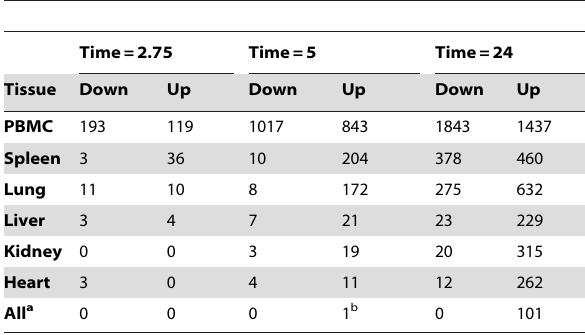
Table 1. Tissue and time specific counts of differentially expressed probesets shown at each time point.